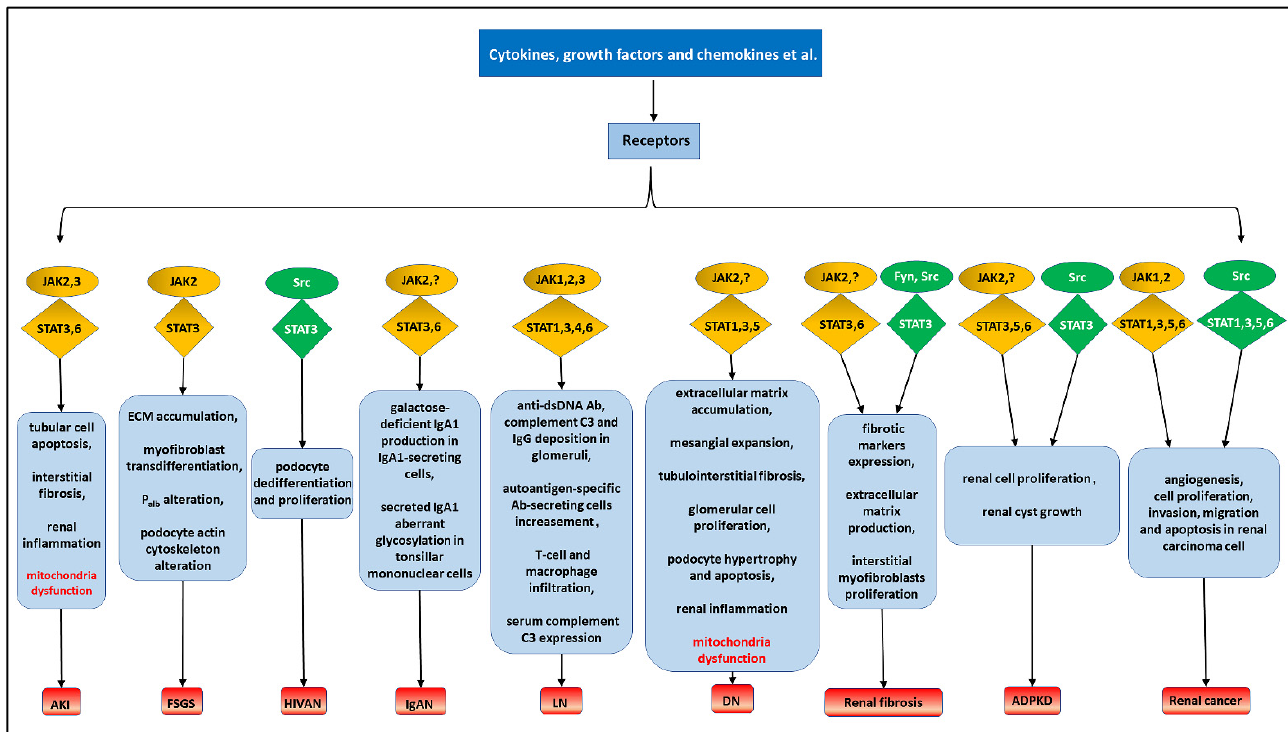
Figure 3. Overview of STAT signaling pathways involved in renal diseases. Ligands-receptors-kinases-STAT axis can mediate different biological events and regulate numerous renal diseases. Yellow circles: typical receptor tyrosine kinases JAKs. Green boxes: non-receptor tyrosine kinases SFK. Red fonts: non-canonical functions of STAT signaling pathways.